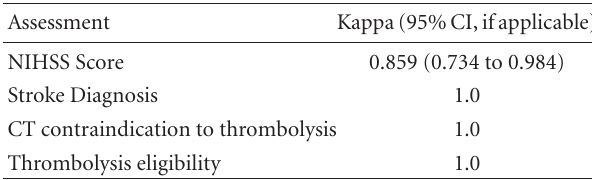
Table 2: VN-NP and Vascular Neurologist Inter rater